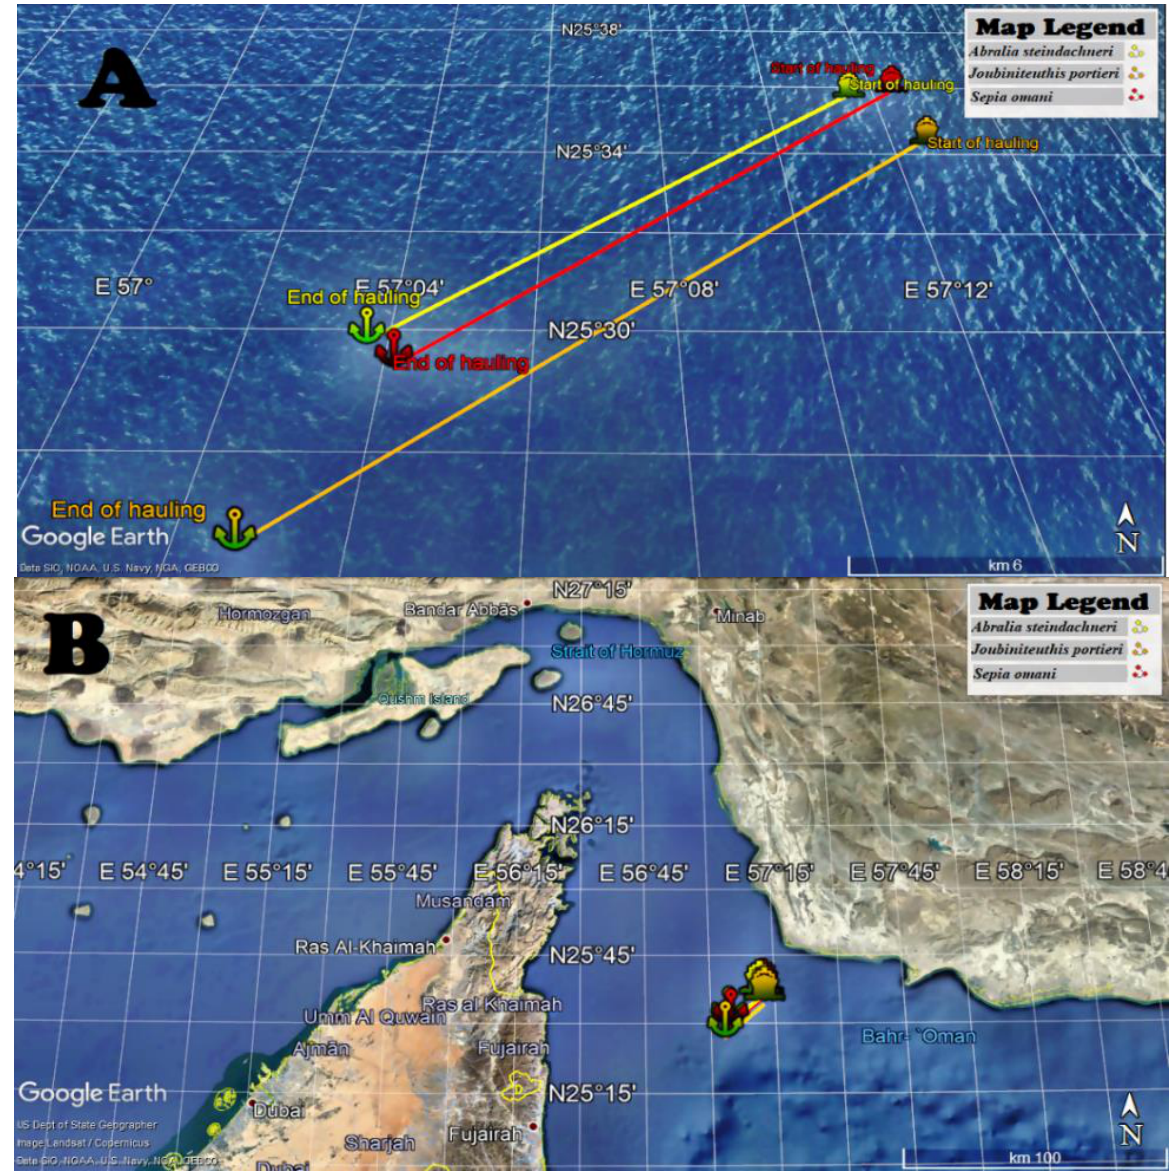
F IGURE 1. Geographical coordinates of studied area. A) hauling path for each species; B) study area in Iranian waters from north of the Gulf of